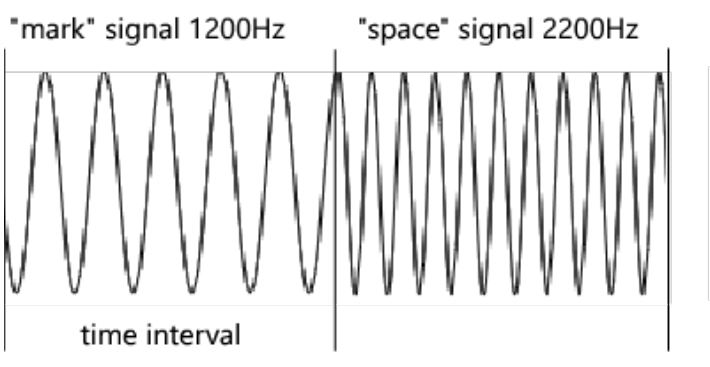
Figure 2. An example of modulations of audio waves used in Bell